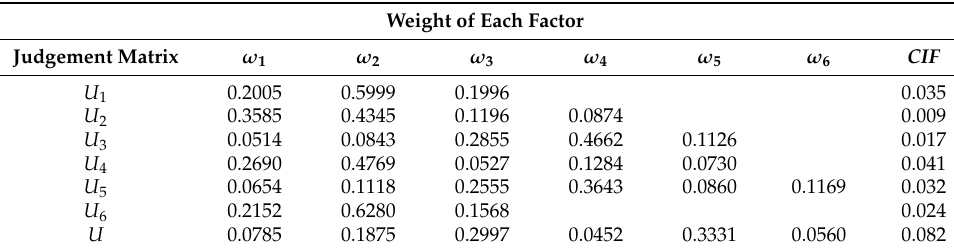
Table 5. Calculation Results of Weights of Various